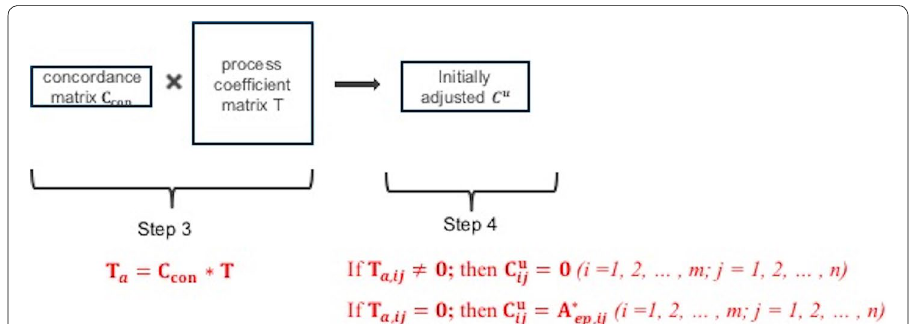
Fig. 5 Workflow for preliminary adjustment for double